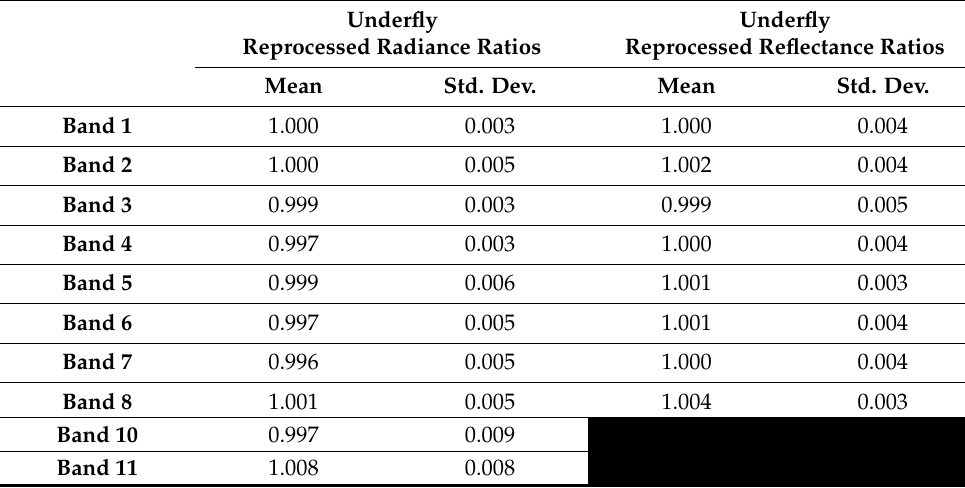
Table 8. Cross-calibration validation results. Note bands 10 and 11 were not calibrated in reflectance space.